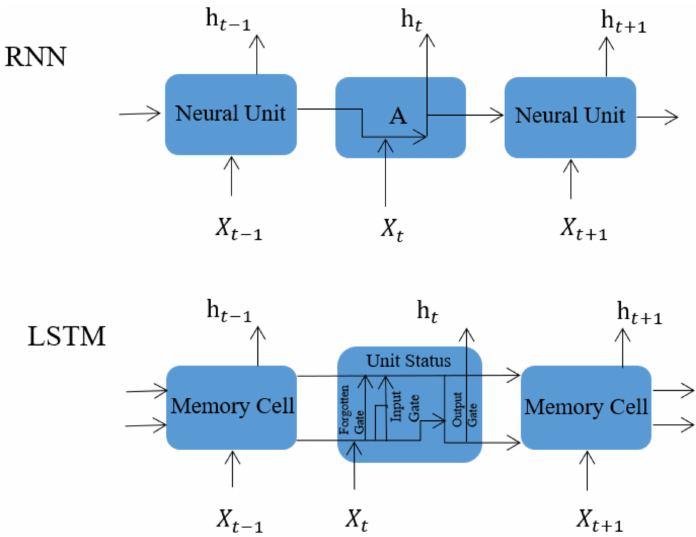
Figure 6. Comparison of the RNN and LSTM